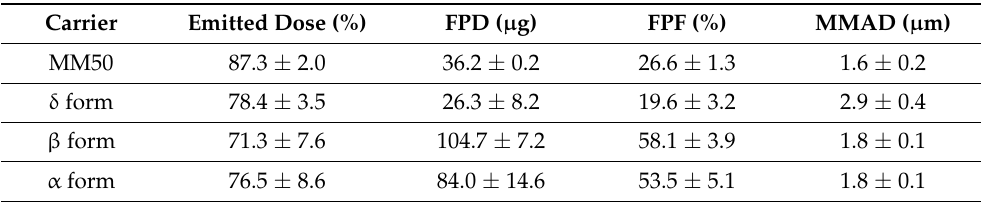
Table 5. Deposition profiles of budesonide from MM50, α , β and δ in an ACI after aerosolization with RS01 at 60 L min − 1 [Mean (SD), n = 3].